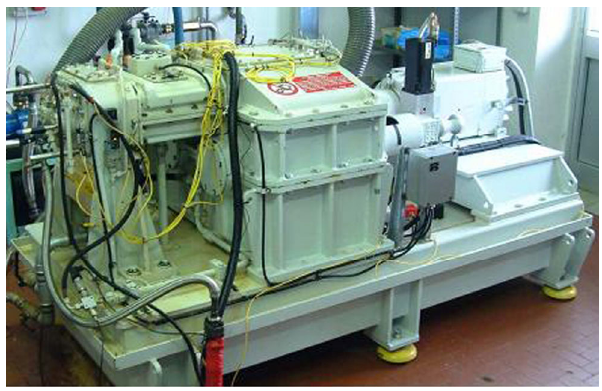
Fig. 14 Image of closed loop test